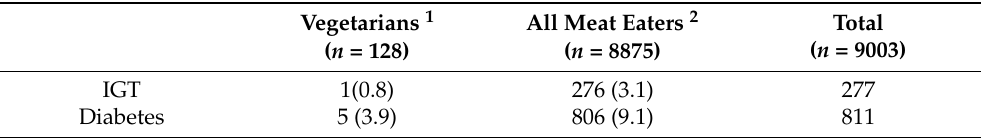
Table 3. Prevalence rates of IGT and diabetes in Vegetarian and All Meat Eaters groups. Data are presented as count and (percentage).